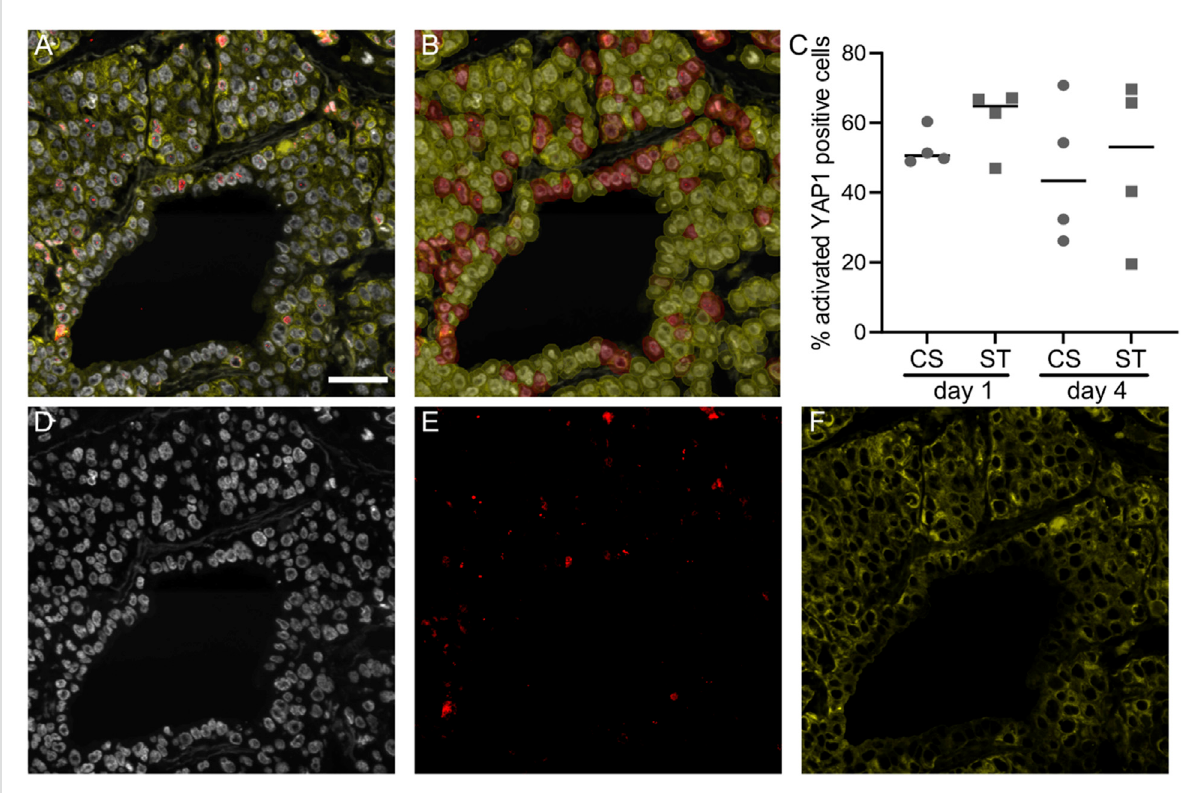
FIGURE 4 Activated YAP1 staining and quanti fi cation. Representative image of lung slices stained against activated YAP1 (red), epithelial marker pan- cytokeratin (yellow) and nuclei (DAPI, white), (A) . Classi fi cation overlay from the QuPath software showing cell classi fi cation from the area shown in (A,B) , activated YAP1 staining was thresholded in cell nuclei to classify cells as either positive (magenta) or negative (yellow). Quanti fi cation of activated YAP1 positive cells (C) , data points represent data from individual lung slice samples, horizontal lines show group median. Individual channels from (A) are shown in (D – F) . Scale bar is 50 μ m, CS: cyclic stretch (circles), ST: static culture